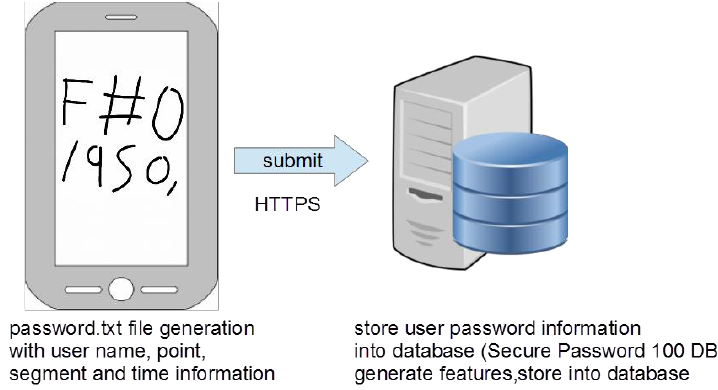
Figure 2. Structure of the writer verification process using database secure-password-DB-150.